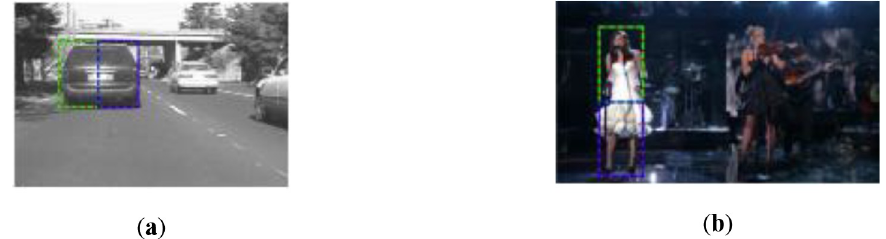
Fig 1. Two spatial distributions based on the ratio of the height and width of the target. The red rectangle represents globe-part, the green and blue rectangles represent two sub-part. ( a ) horizontally aligned object from car4 ; ( b ) vertically aligned object from single1 ;.